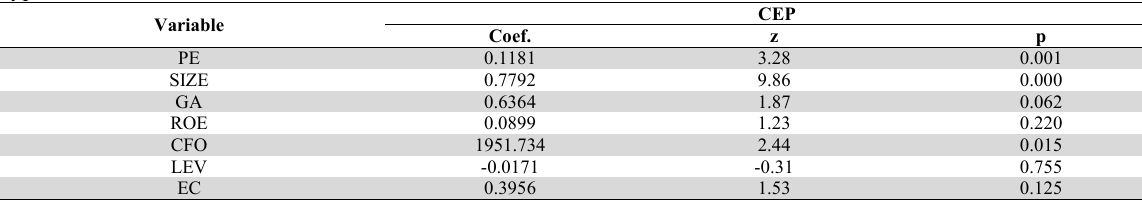
Hyphothesis 3b test result